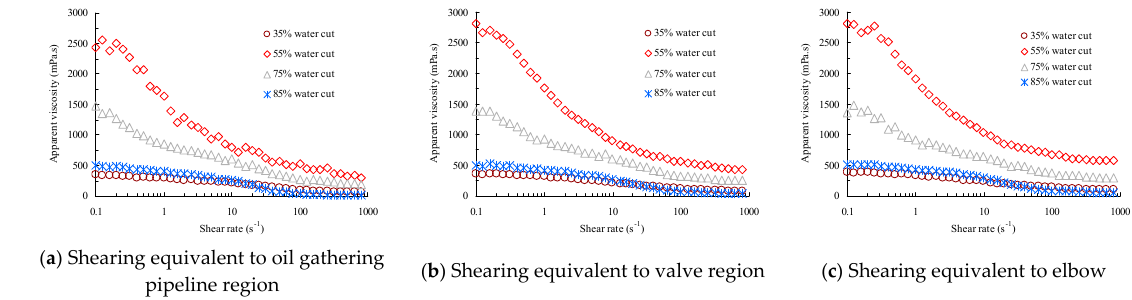
Figure 8. The viscosities of waxy crude oil emulsions as a function of shearing rate. 5.4. Droplet Size and Droplet-Size Distribution of the Waxy Crude Oil Emulsions The droplet-size distributions of typical emulsions in different shearing patterns are shown in Figure 9. It indicated that the droplet diameters of emulsions concentrated at 0.5~80 µ m, the distribution range would be wider when the emulsion changed into the type with water being the continuous phase. The droplets of the dispersed phase also began to coalesce to form larger droplets until the dispersed phase became the continuous phase, and the mean diameter was larger than 50 µ m when the water fraction was over 75% according to the experimental results. Moreover, the suffered shearing in